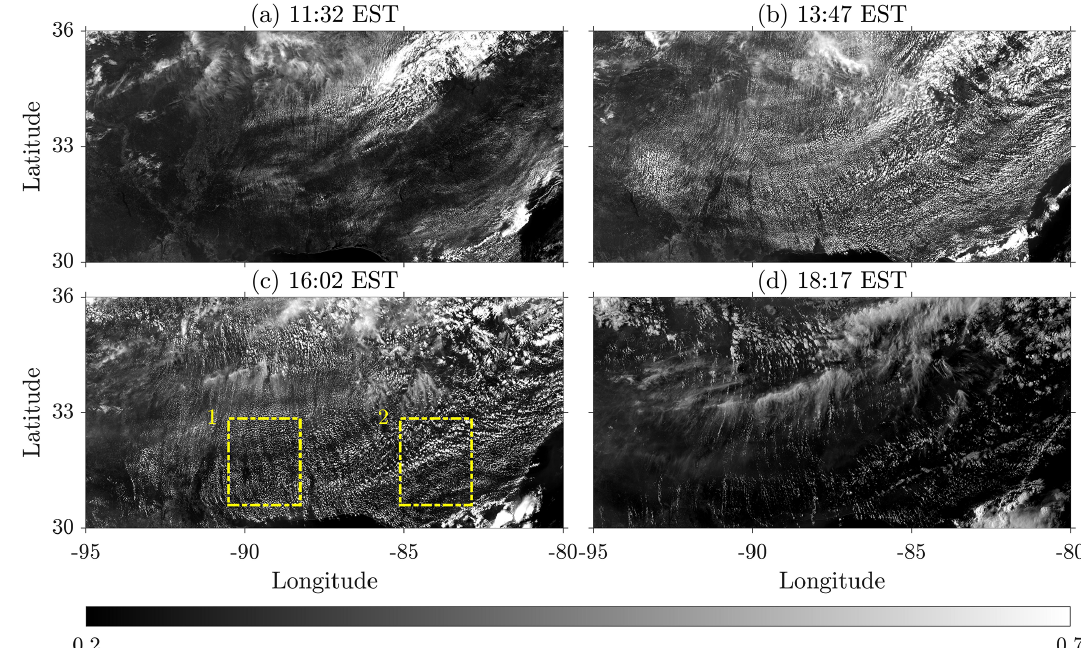
Figure 1. Corrected reflectance field of the diurnal cloud evolution as obtained from GOES-16 ABI’s Red visible band (channel 2; 0 . 64µm). Snapshots taken at 11:32 (a) , 13:47 (b) , 16:02 (c) , and 18:17EST (d) . Dashed boxes in (c) represent two subdomains analyzed in Fig. 3.